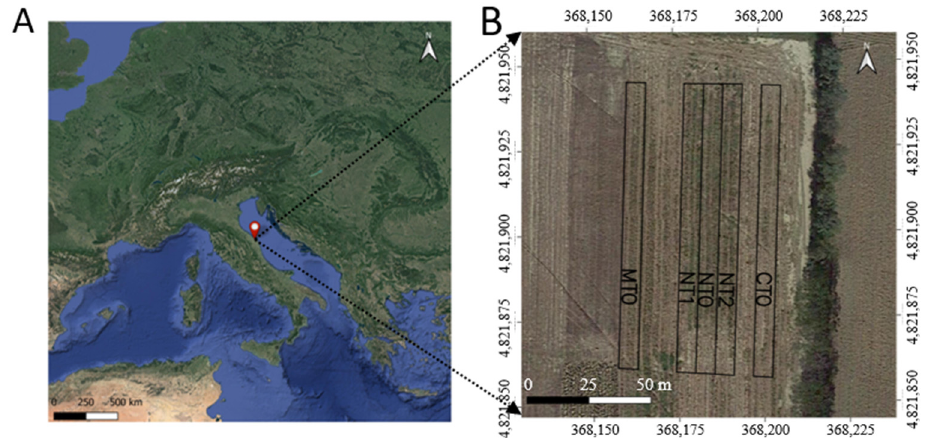
Figure 1. ( A ) “Pasquale Rosati” experimental farm of Università Politecnica delle Marche, Agugliano, Ancona (Italy) (coordinate system: WGS 84/UTM zone 33N, 100 m a.s.l.) (red point). ( B ) Subdivision of the experimental site in relation to tillage methods and nitrogen fertilizer treatments: conventional tillage without fertilization (CT 0 ); minimum tillage without fertilization (MT 0 ); no tillage without fertilization (NT 0 ); no tillage with 90 kg N ha − 1 fertilization (NT 1 ), and no tillage with 180 kg N ha − 1 fertilization (NT 2 ).